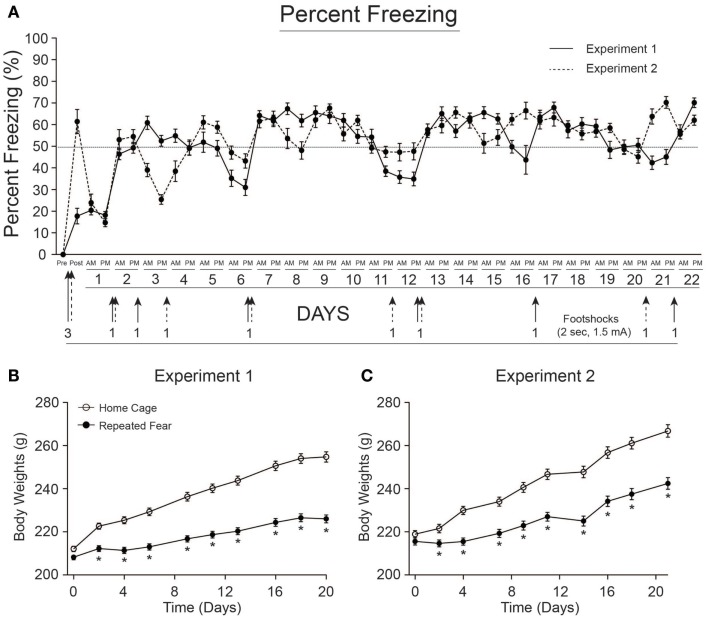
Freezing behavior and body weights for rats used in Experiments 1 and 2. (A) Freezing was scored before (pre) and after (post) administration of 3 foot shocks during contextual fear conditioning on day 0. Rats were re-exposed to the conditioned context twice a day, early (a.m.), or late (p.m.) during the light cycle, for 22 days. Re-instatement shocks (denoted by arrows) were administered at the end of the p.m. session when average freezing fell below 50%. The number of shocks administered is noted next to each arrow. Rats in both Experiment 1 (B) and Experiment 2 (C) exposed to repeated fear stress gained less weight over time relative to home cage control rats. *p < 0.05 relative to home cage control.